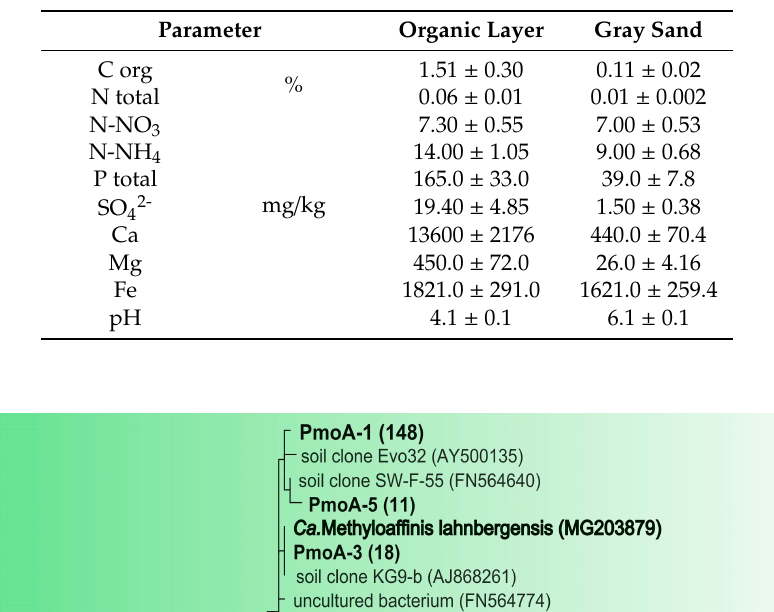
Table 1. Chemical composition of soil samples.